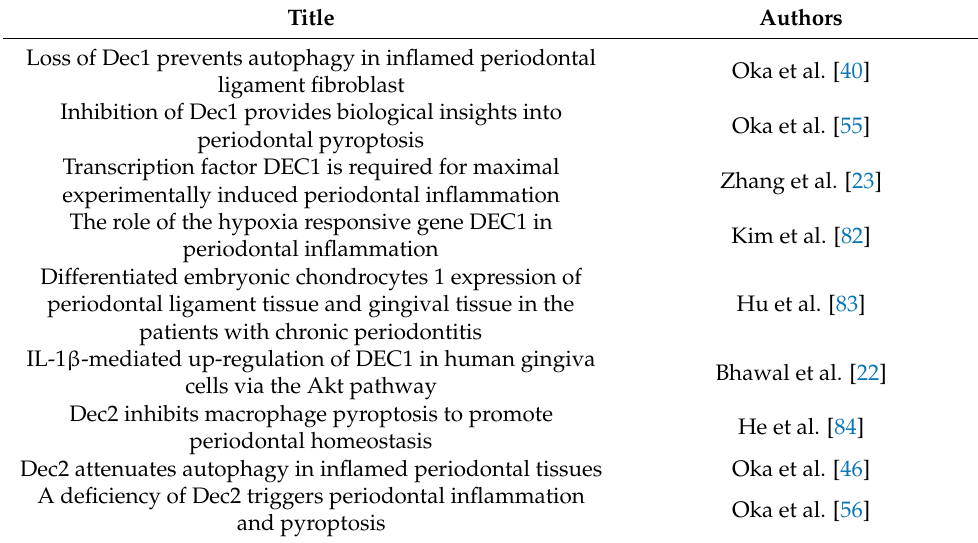
Table 1. Studies represent functions of Dec1 and Dec2 in periodontal pathological processes.